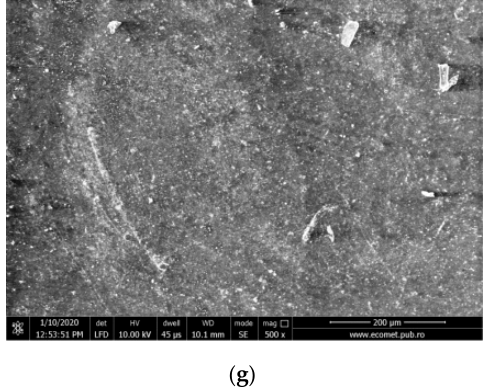
Figure 3. Scanning electron microscope (SEM) images for post-consumer rPP loaded with styrene-butadiene-styrene/styrene-isoprene-styrene block-copolymers and glass bubbles: ( a ) rPP (scale bar 200 μ m); ( b ) rPP/SBS (scale bar 300 μ m); ( c ) rPP/SBS/GB 5 (scale bar 300 μ m); ( d ) rPP/SBS/GB 20 (scale bar 300 μ m); ( e ) rPP/SIS (scale bar 200 μ m); ( f ) rPP/SIS/GB 5 (scale bar 200 μ m); ( g ) rPP/SIS/GB 20 (scale bar 200 μ m).